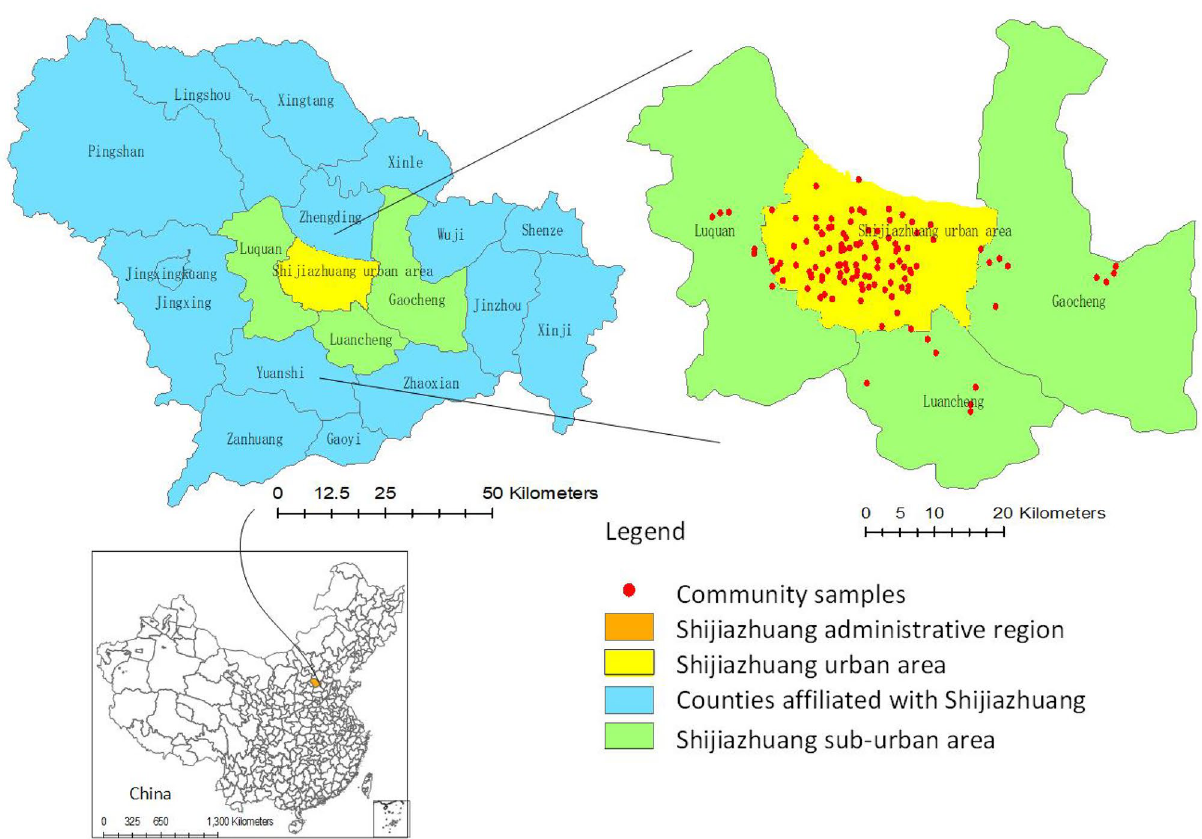
Figure 1. Study area and community sample distributions (made with acgGIS10.2, https:// suppo rt. esri. com/ en/ downl oad/ 2089).